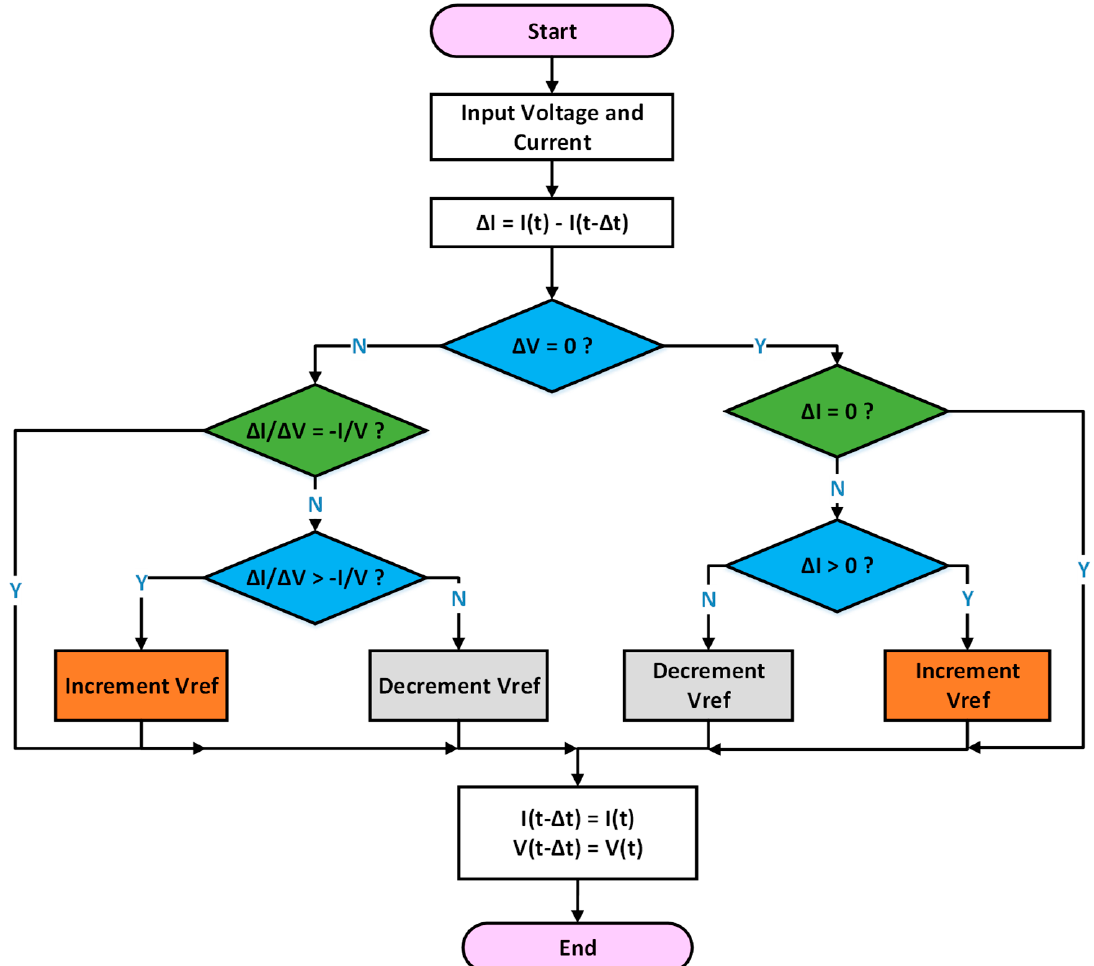
Figure 7. MPPT based on an incremental conductance flow chart [39] .